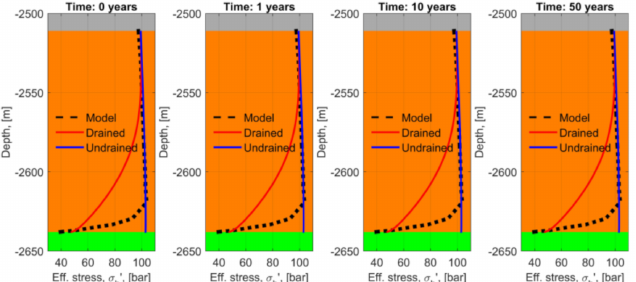
Figure 11. Comparison of the effective horizontal stress in caprock (Drake Fm.) in the numerical model (black dashed curves) to the effective horizontal stress calculated using analytical expres- sion for drained conditions (red curves, Equation (20)) and undrained conditions (blue curves, Equation